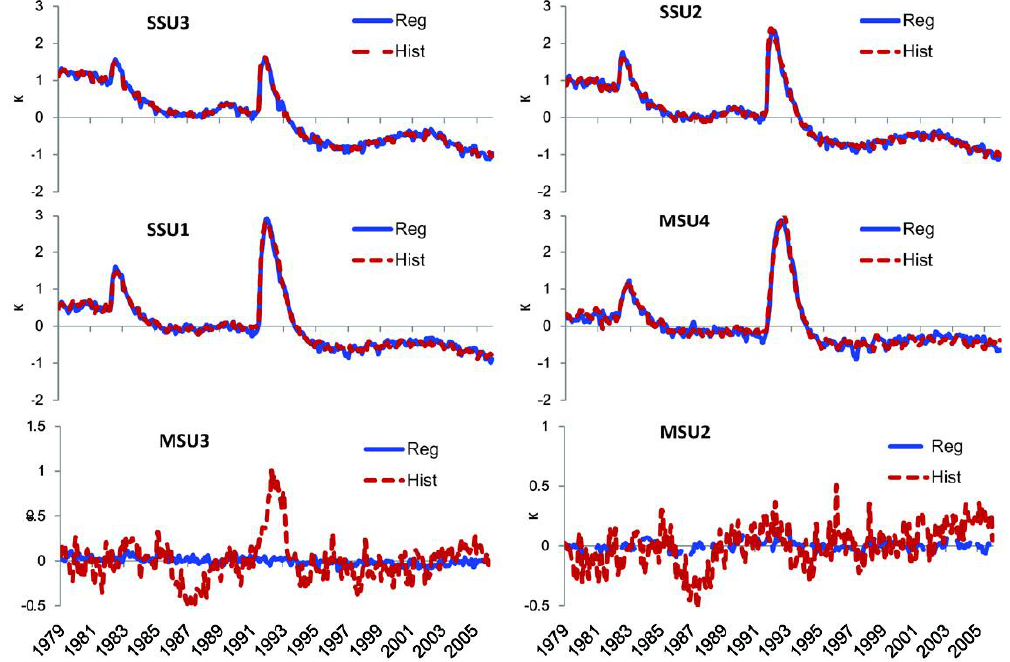
Figure 10. Global mean temperature anomalies simulated by MRI-CGCM3 at SSU1-SSU3 and MSU2-4. Red dash line represents the historical run (Hist). Blue line indicates the multiple linear regression results (Reg) with greenhouse gases forced run (GHG) natural forced run (NAT) and pre-industrial control run (PI).